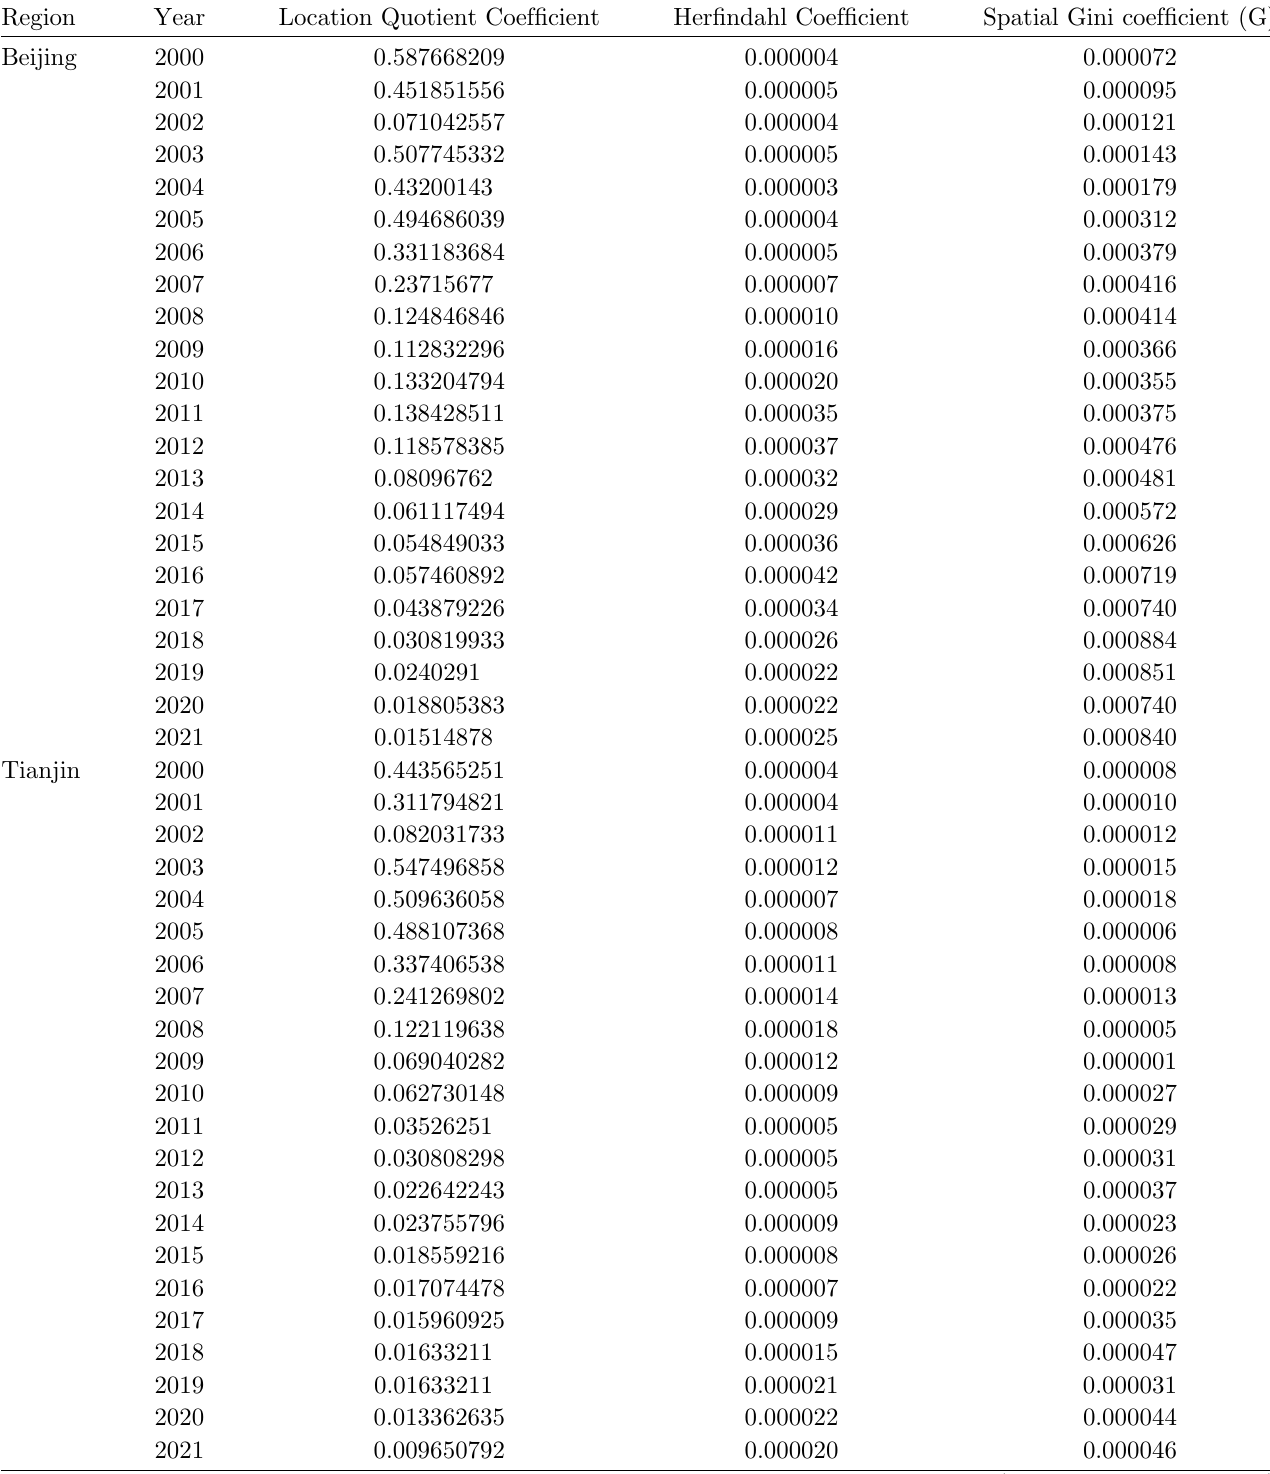
Table A1. Beijing – Tianjin – Hebei renewable energy industry agglomeration indexes.